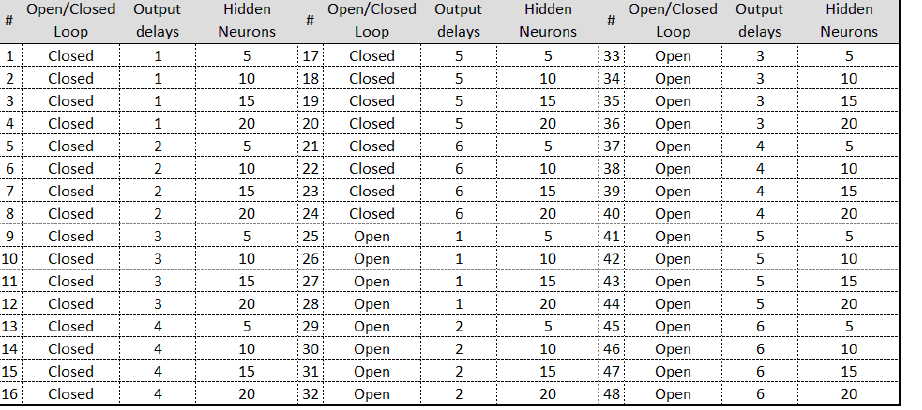
Figure 10. Identification of the networks in Figure 9, in relation to the number of neurons, the hidden layer, delays in the outputs used and whether the network is open or closed